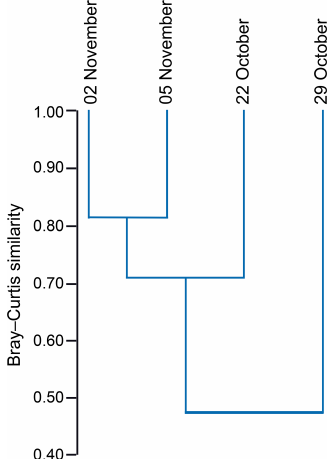
Figure 5. Hierarchical cluster analysis showing the similarity of foraminiferal assemblages from station 1 and station 2 between dif- ferent sampling days (day/month) in 2012. Cluster analysis was per- formed using the unweighted pair group method with arithmetic mean (UPGMA) based on the Bray–Curtis similarity index (values from 0 to 1; 1 indicates the highest similarity between the